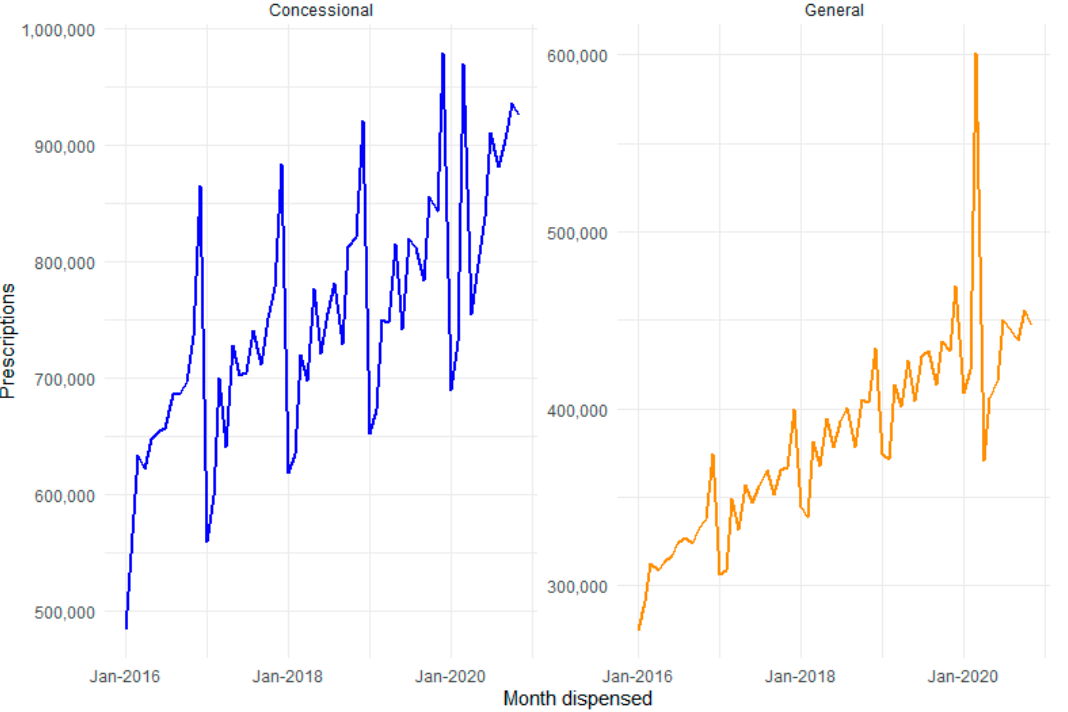
Figure 3. PBS dispensed diabetes medicines by patient category.